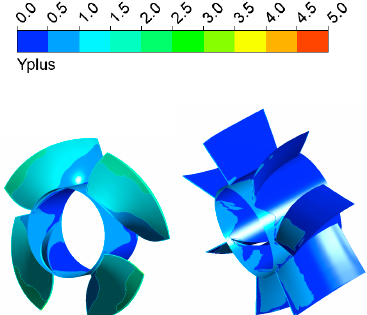
Figure 4. The y + distribution of grids near the wall of impeller and guide vane.